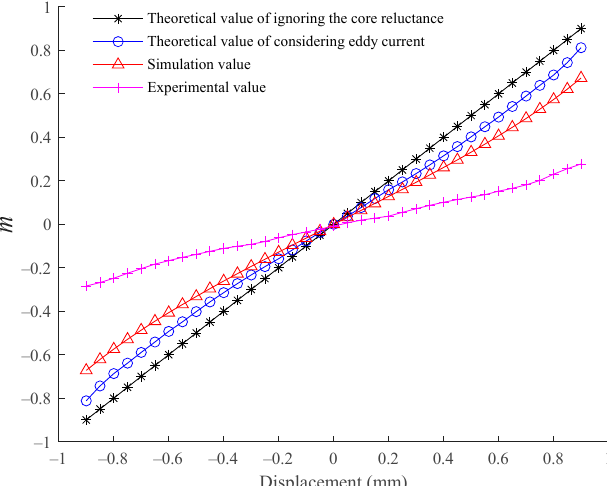
Figure 14. Variation of m with the rotor displacement.